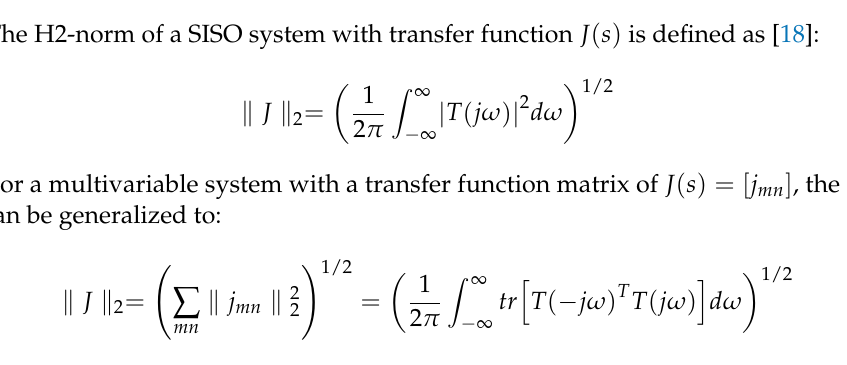
Figure 3. Standard representation of the H2 optimal control